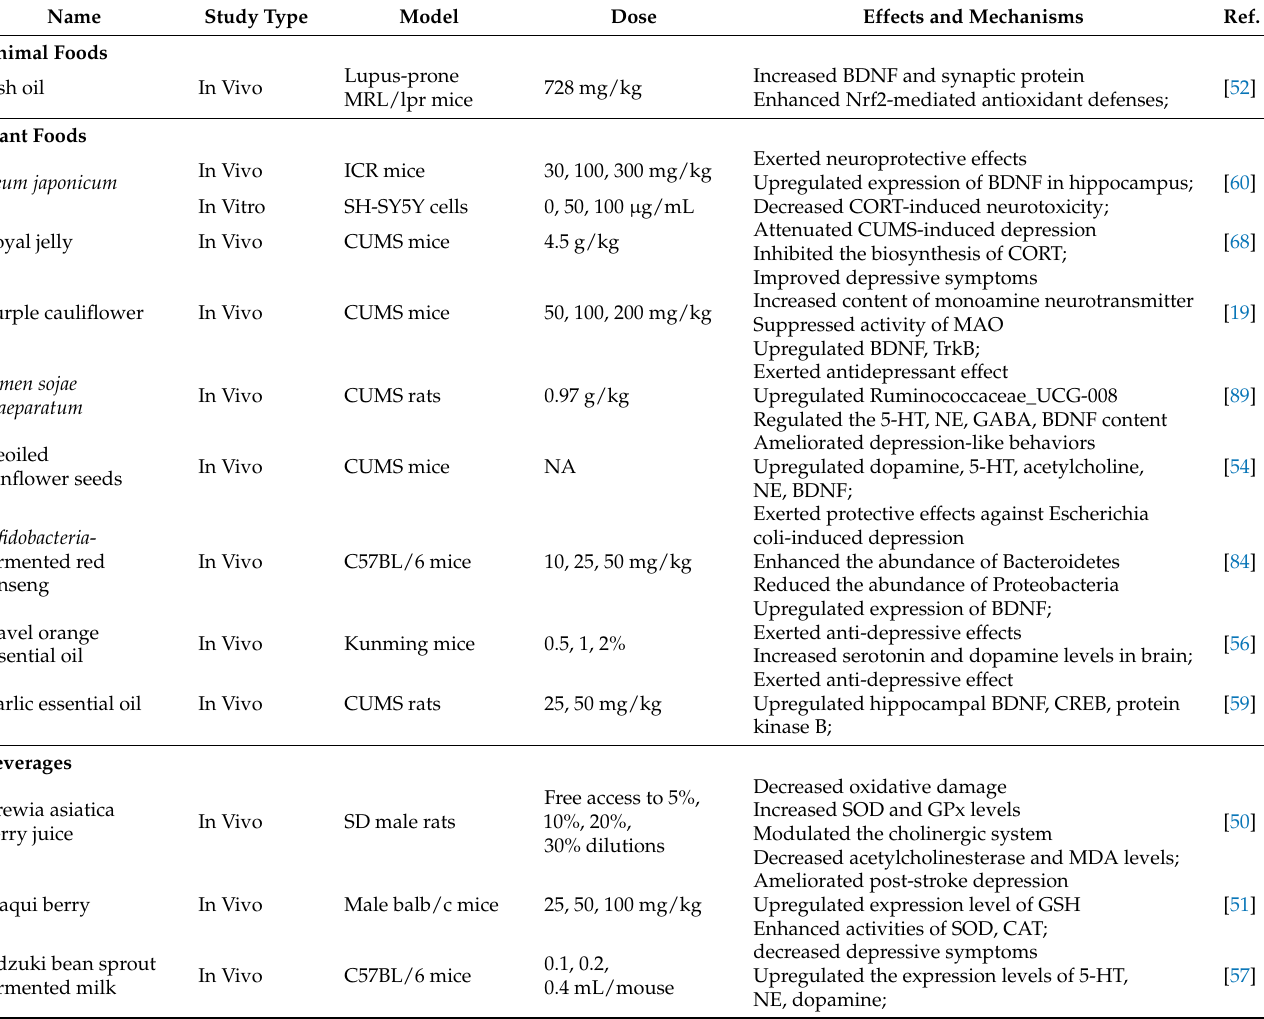
Table 2. Effects and mechanisms of dietary natural products and nutrients on depression from experimental